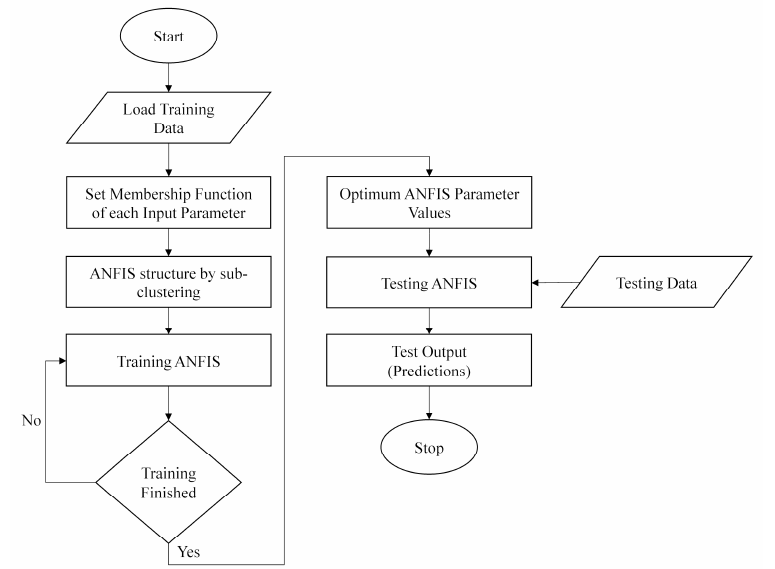
Figure 11. Algorithm flowchart of the ANFIS model used in the present study to model the landslide chances. All the ANFIS simulations were conducted using the ANFIS, Fuzzy Logic toolbox of MATLAB v. 7.0. The ANFIS model was tested by running the model in the MATLAB en- vironment. An example prediction was generated using the model. The prediction gener- ated was found to be highly significant and accurate. The model showed a minimal train- ing error RMSE = 0.000299 and an average testing error of 0.048609, which is very low; so, the model can be considered a best-fit model for landslide predictions. The MATLAB code used for the ANFIS model execution in Fuzzy Logic toolbox environment was as follows: Details of the ANFIS model. Number of nodes: 4426 Number of linear parameters = 2187 Membership function type = Trimf Number of membership functions = 3 Total number of parameters = 2250 Number of nonlinear parameters = 63 Number of fuzzy rules = 2187 Number of training data pairs = 158 Model Execution. g= readfis (‘T335.fis’); r = input (‘RF (Rainfall in mm (1-4)) =’); a = input (‘LST (Land Surface Temperature (284-306)) =‘); b = input (‘SM (Soil Moisture (283-305)) =‘); c = input (‘SLP (Slope (6-66)) =‘); d = input (‘DTRD (Distance to Road (1-45)) =‘);